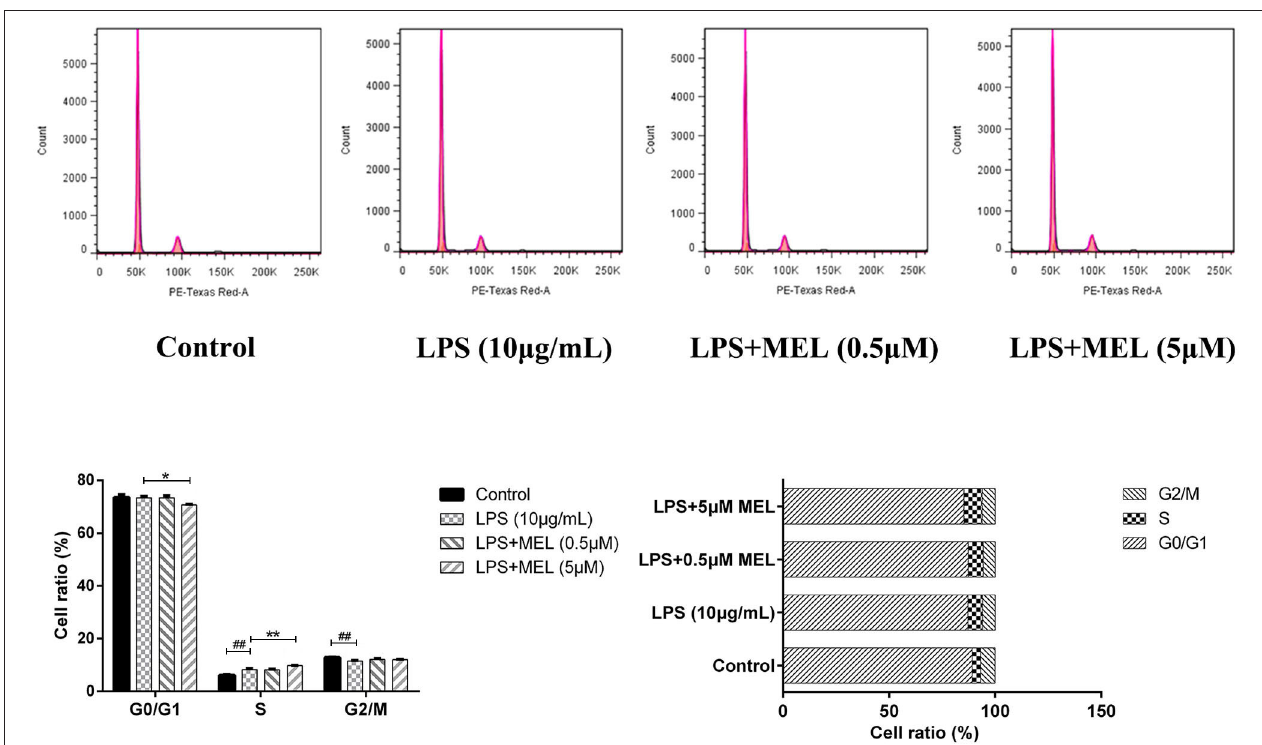
FIGURE 7 | The effect of meloxicam on the cell cycle distribution of bovine endometrial epithelial cells stimulated with lipopolysaccharide. LPS, lipopolysaccharide; MEL, meloxicam. The cells were treated with LPS or co-treated with LPS and MEL (0.5 and 5 µ M) for 24h. The cell cycle distribution was detected by flow cytometry and was analyzed by FlowJo software 7.6 to obtain the relative number of cells in each phase of the cell cycle. # P < 0.05, difference compared with the control; ## P < 0.01, difference compared with the control; * P < 0.05, difference compared with the LPS treatment group; ** P < 0.01, difference compared with the LPS treatment group. All data were presented as means ± SEM ( n =